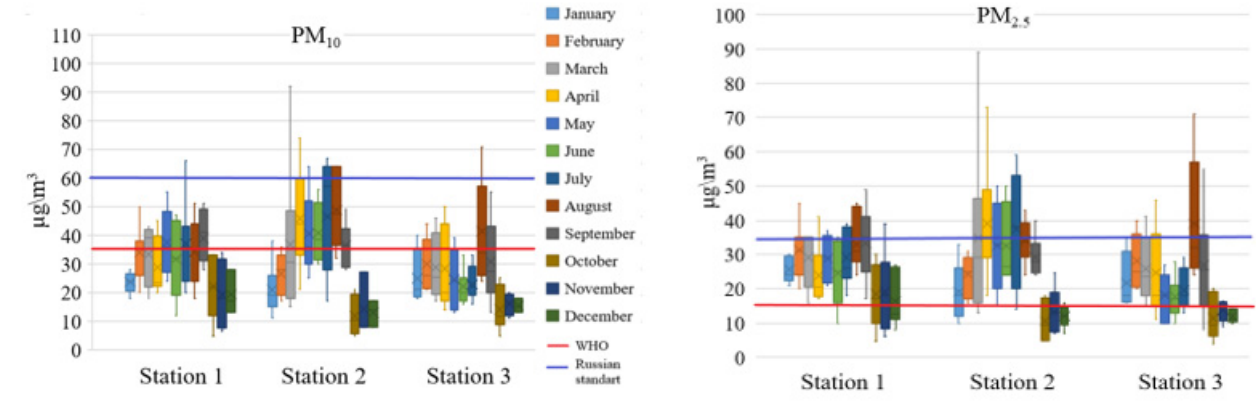
Figure 2. 24-h PM 10 and PM 2.5 concentration measured in 2020 by the Atmas device. The mean PM 10 ranged between 6 and 64 μ g/m 3 . PM 2.5 levels were reported from 5 to 56 μ g/m 3 . About 3% of PM 10 and 30% of PM 2.5 values exceeded the Russian standard val- ues (35 and 60 μ g/m 3 , respectively) by 1.1 to 1.7 times. It should be noted that Russian